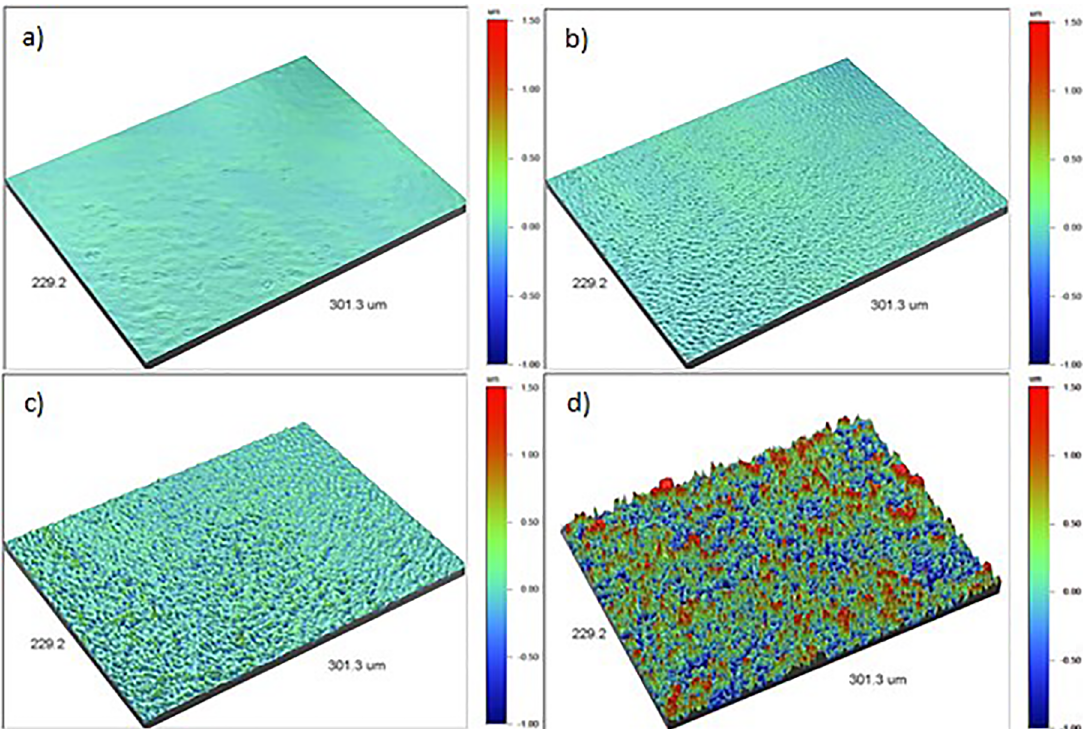
Figure 1. Profilometry topographies (area: 229.2 × 301.3 µm, scale: −1.0 to +1.5 µm) of polished Ti6Al4V samples. (a) untreated control and (b–d) surfaces exposed to piranha solution for 30 min at 25 °C, 40 °C, and 60 °C,